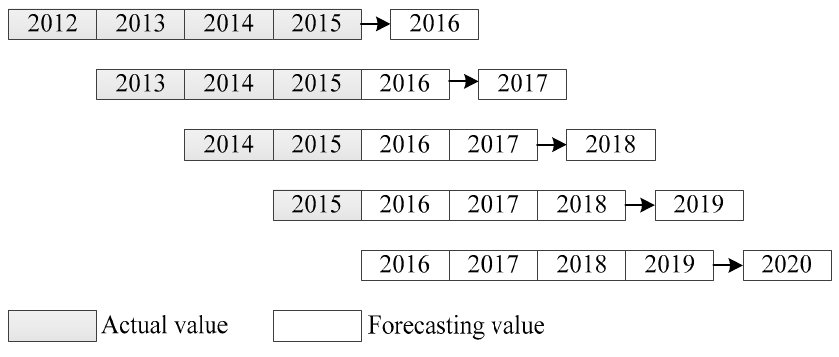
Figure 3. Schematic of the rolling mechanism. Table 4. Forecast of China’s sulfur dioxide emissions (unit, million tons).